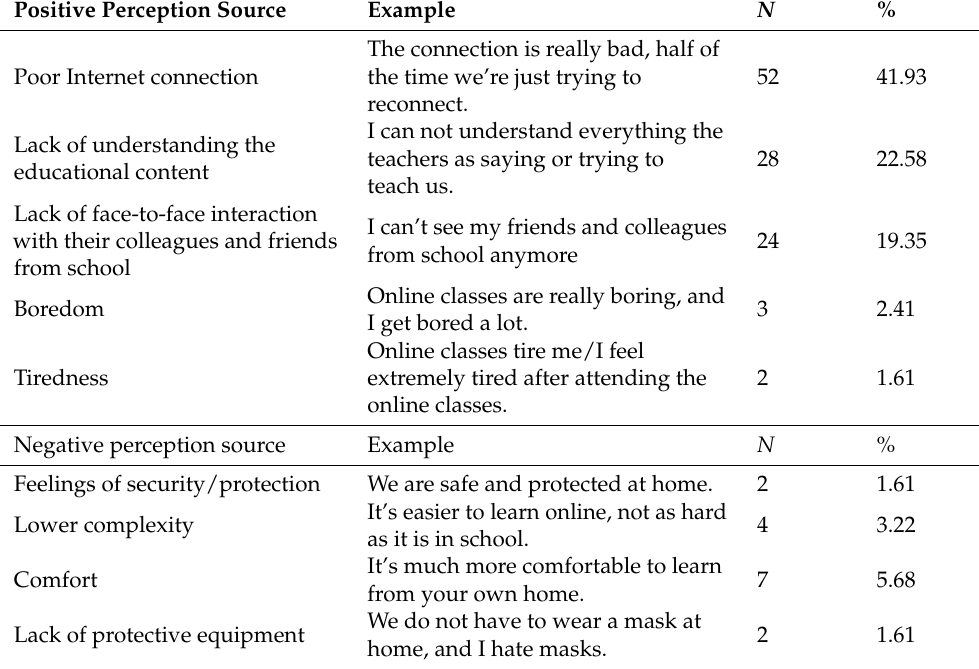
Table 5. Perception of the online classes during the COVID-19 pandemic.